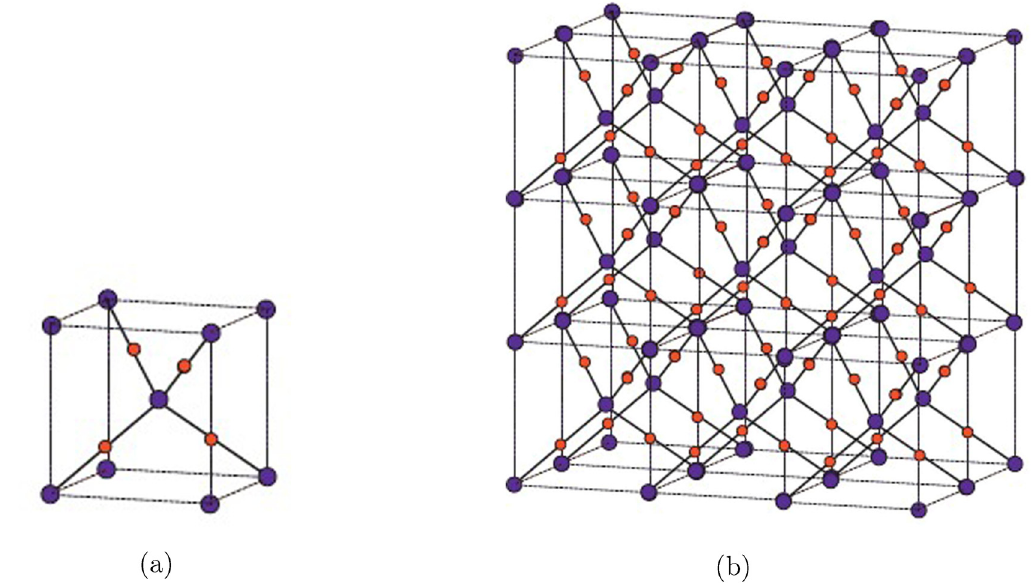
Figure 2: ( a ) Unit cell of [ ] Cu O 1, 1, 1 2 and ( b ) the crystallographic structure of [ ] Cu O 3, 2, 3 2